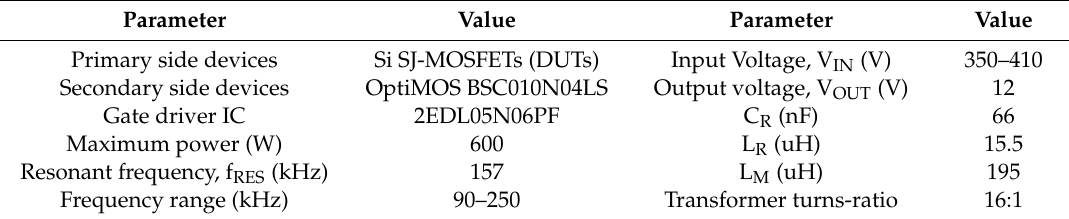
Table 2. LLC resonant converter evaluation board specifications.